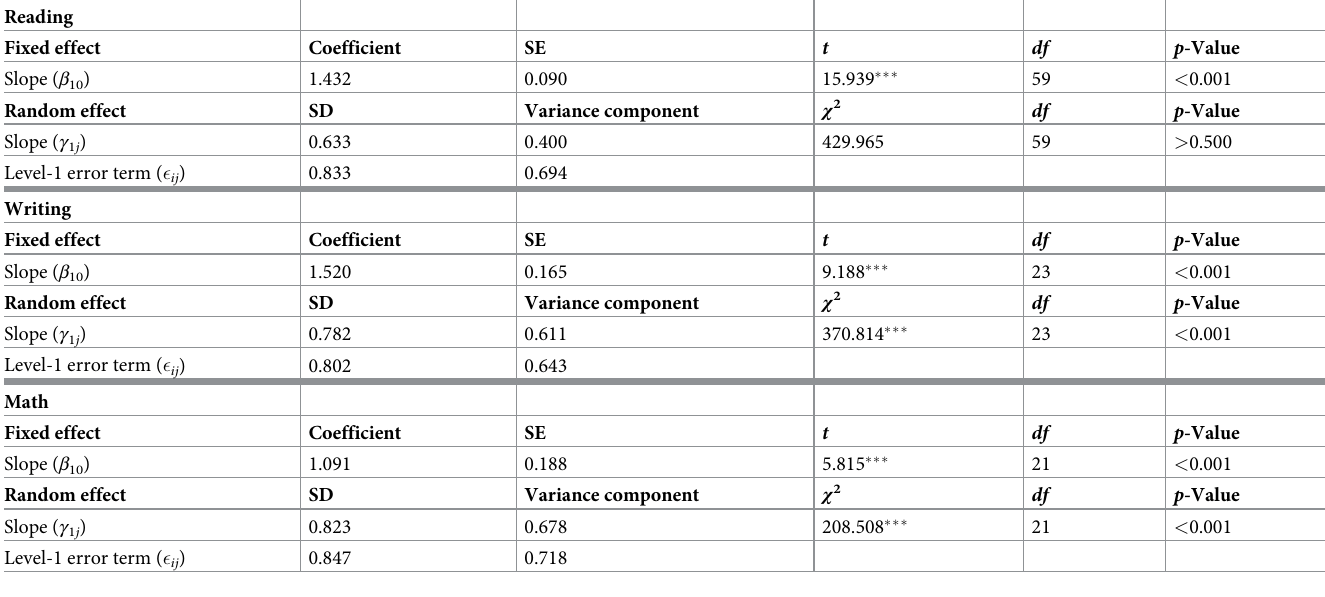
Table 9. Results from the unconditional model for reading, writing, and math. Reading